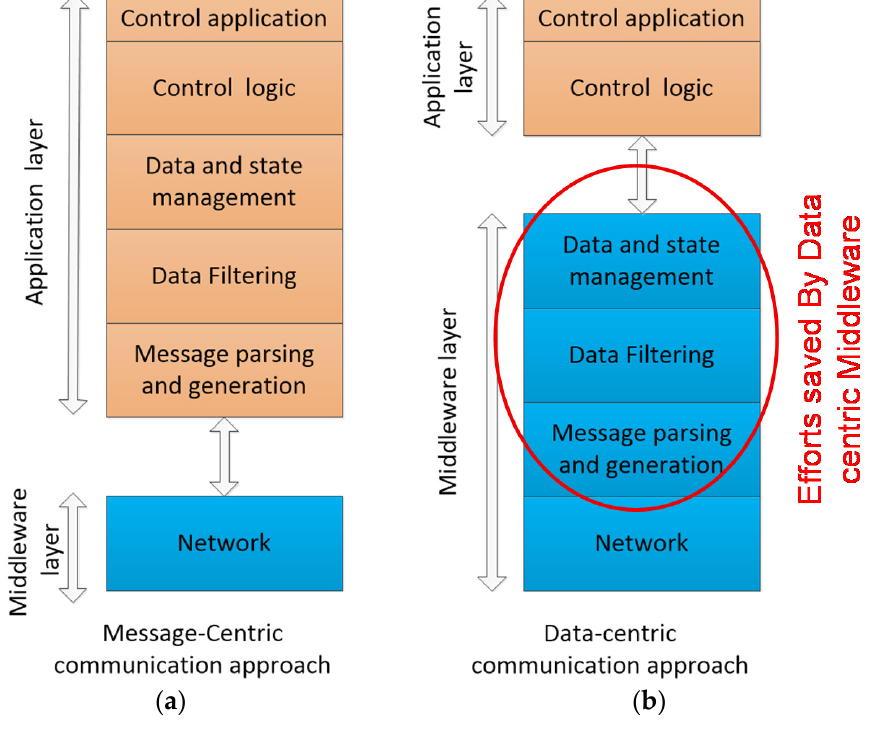
Figure 2. Middleware approaches: ( a ) message ‐ centric; and ( b ) data ‐ centric as described in [18].